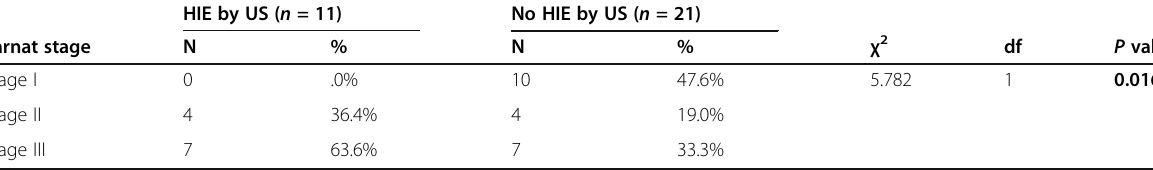
Table 4 Relation between US evidence of HIE and Sarnat stages HIE by US ( n = 11) No HIE by US ( n = 21) Sarnat stage N % N